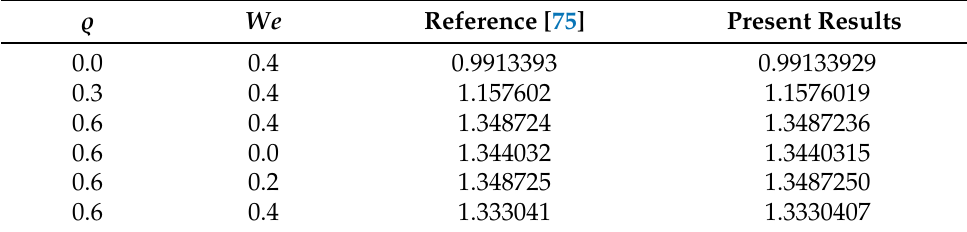
Table 1. Computation of C fx for changing (cid:36) and We , for Rd = Sr = M = Du = Sc = 0. (cid:36)